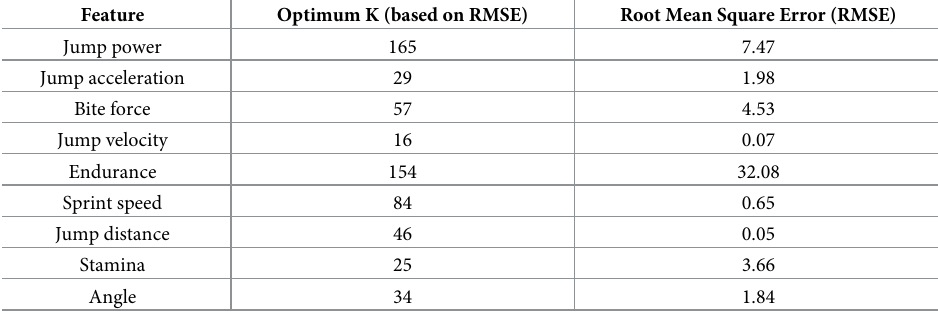
Table 2. Optimum K-value search result (range 1 to 100), for various performance